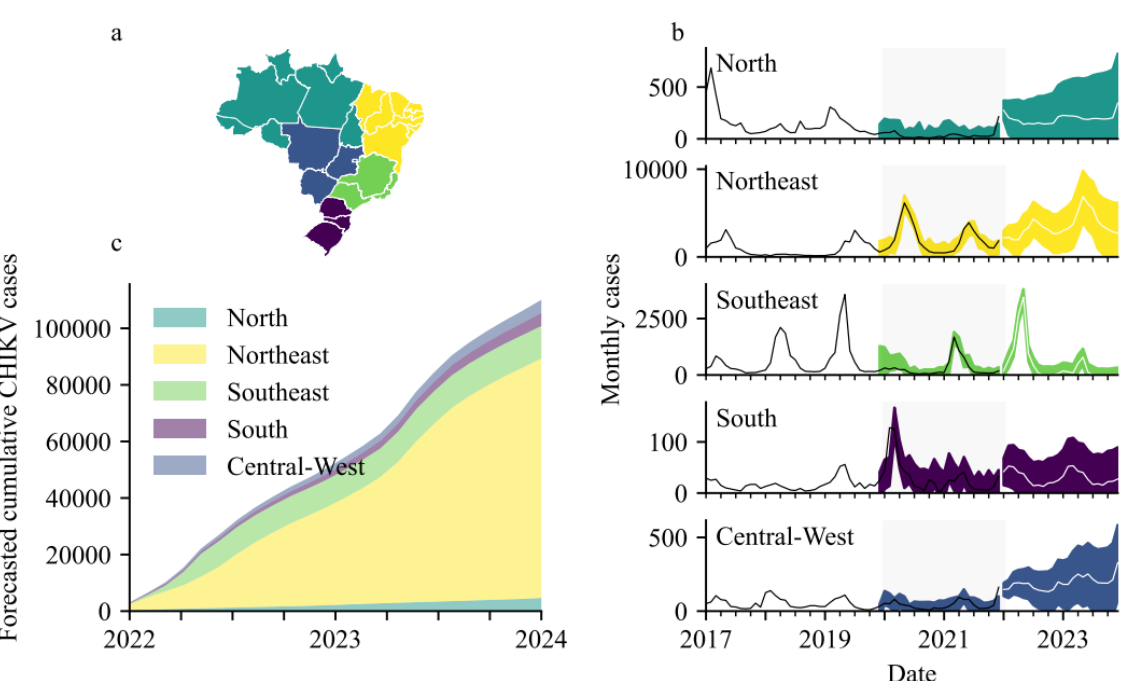
Figure 2. ( a ) How the 26 Brazilian states are categorized according to Region. ( b ) Region level SARIMA models with the grey segments denoting model validation time window (please note different scale on y-axes). ( c ) Forecasted cumulative CHIKV cases (serologically confirmed).